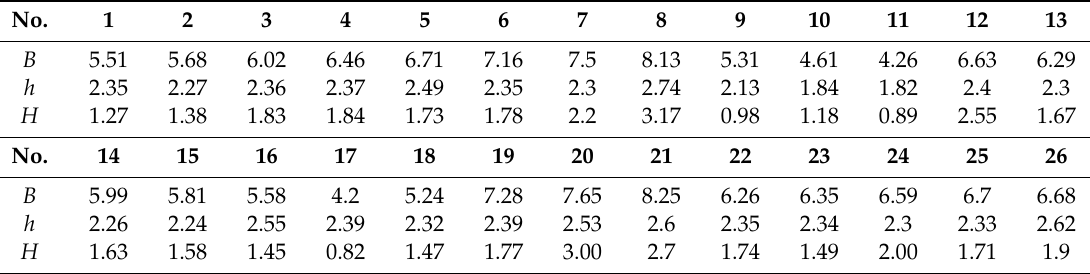
Table 4. Measurement of the weld bead (\mm).